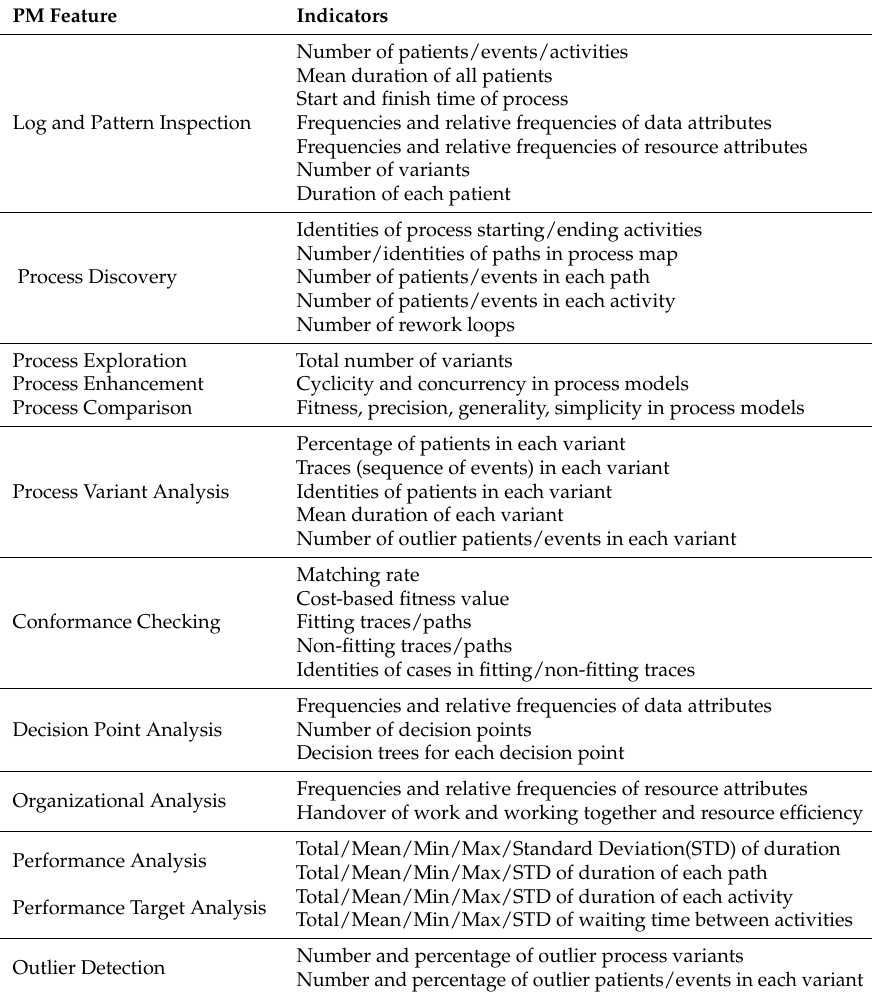
Table 2. Indicators that can be measured by PM